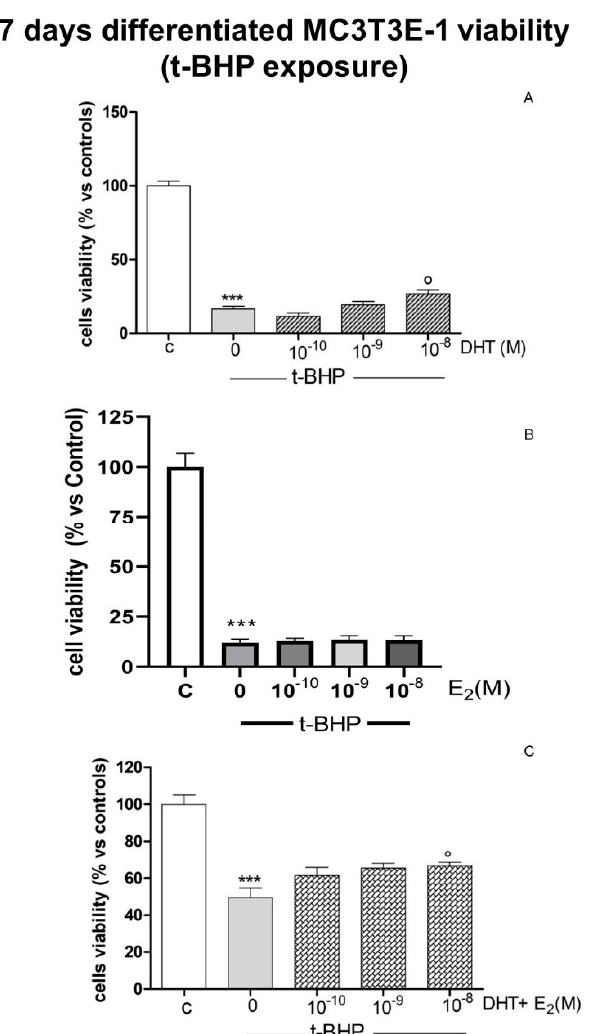
Figure 2. Effects of steroids on counteracting t-BHP-induced oxidative stress in 7-day differentiated osteoblasts MC3T3-E1 cells. Effects of steroids (10 − 10 –10 − 8 M) on t-BHP-induced cytotoxicity in 7 day- differentiated osteoblasts MC3T3-E1 cells. Cells were pre-treated with E2 or DHT or a combination of both (doses between 10 − 10 M and 10 − 9 M), 24 h before being treated with t-BHP (125 µ M for 3 h). We measured cell viability by MTT assay 2 h after treatment. ( A ): effects of DHT on t-BHP-induced cytotoxicity in 7-day-differentiated osteoblasts MC3T3-E1 cells; ( B ): effects of E2 on t-BHP-induced cytotoxicity in 7-day-differentiated osteoblasts MC3T3-E1 cells; ( C ): effects of a co-treatment of E2 + DHT on t-BHP-induced cytotoxicity in 7-day-differentiated osteoblasts MC3T3-E1 cells. We represented data as the mean ± SEM of six replicates within a single experiment. Column C represents the control (w/o steroids treatment and w/o t-BHP exposure), Column 0 represents the t-BHP group w/o steroids. MC3T3-E1 cells were treated via increasing concentrations of steroids 10 − 10 , 10 − 9 , and 10 − 8 M were exposed to t-BHP. The experiment was repeated three times. Differences between groups were evaluated by one-way ANOVA, followed by Bonferroni post-hoc test. *** p < 0.001 vs. control, ◦ p < 0.05 vs.